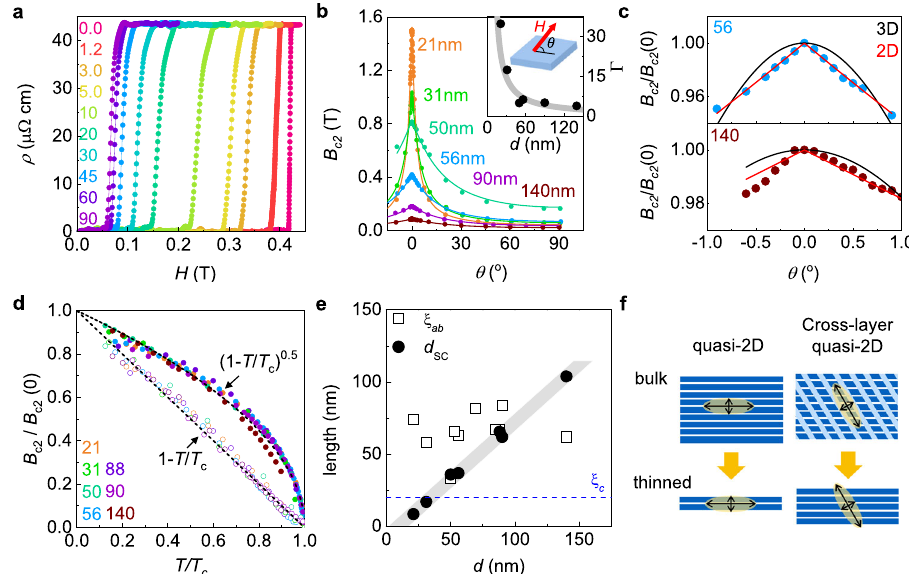
Fig. 3 Two dimensional superconductivity of IrTe 2 nano fl akes. a , Magnetic fi eld dependence of ρ ( H ) of a 56-nm-thick IrTe 2 nano fl ake, measured with different fi eld orientations θ at T = 0.35 K. b , Upper critical fi eld B c 2 as a function of fi eld angle θ for IrTe 2 nano fl akes with different thickness ( d ) at T = 0.35 K, together with the fi t (solid line) to the 2D Tinkham model. Inset: the anisotropy factor Γ ¼ B ab c / B c c as a function of d , following 1/ d dependence (grey line). 2 2 Schematic illustration shows the fi eld orientation θ . c , Angle dependence of B c 2 ( θ ) of IrTe 2 nano fl akes with d = 56 and 140 nm at T = 0.35 K. Good agreement with the 2D Tinkham model (red), rather than the 3D Ginzburg-Landau model (black), con fi rms the 2D superconductivity. d , Normalised B c 2 / B T / T fl akes with different d . All data collapse into dashed lines described by 1 − T / T ð 1 (cid:3) T = T Þ 1 = 2 for B ∥ c (open c 2 (0) as a function of c for IrTe 2 nano c and c circles) and B ∥ ab (solid circles), respectively. e , Ginzburg-Landau coherence length ξ ab (square) and the effective superconducting thickness d SC (circle) as a function of d . ξ ab is nearly independent of d , whereas d SC grows linearly with d ( d SC ~ 0.8 d ) and exceeds ξ c of doped bulk IrTe 2 . f , Schematic illustration of the size effect of vdW superconductors. In normal vdW superconductors with a large anisotropy ξ c ≪ ξ ab , 2D superconductivity appears only for a-few-layer- thick crystals. In IrTe 2 with a stripe order and the resulting cross-layer quasi-2D state, the increased ξ c ~ ξ ab induces 2D superconductivity in relatively thick nano fl